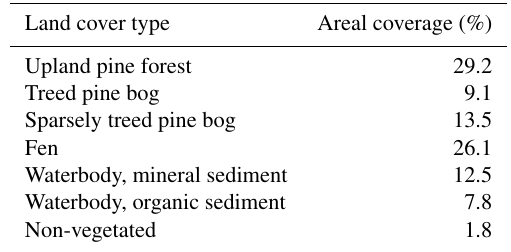
Table 1. Relative areal coverage of the land cover types within the study